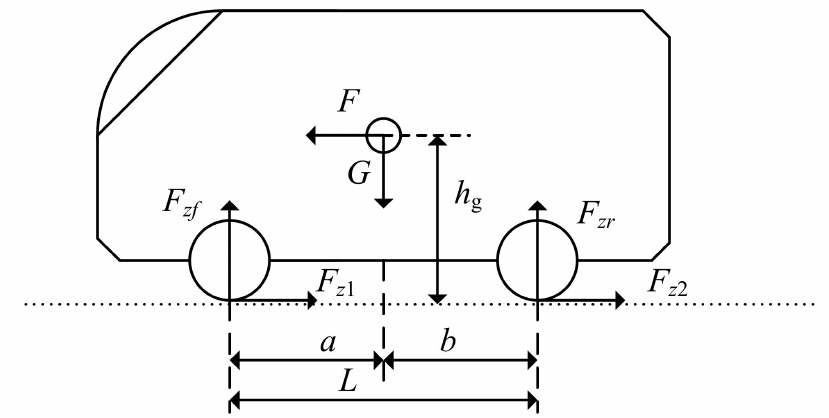
Figure 1. Dynamic force analysis of the pure electric bus when braking. The meanings of the symbols in Figure 1 are as follows: a is the distance from the center of mass of the vehicle to the centerline of the front axle, which is 3728 mm; b is the distance from the center of mass of the vehicle to the centerline of the rear axle, which is 2372 mm; h g is the height of the center of mass of the vehicle, which is 596 mm; L is the wheelbase, which is 6100 mm; G = m g is the gravity of the whole vehicle, and m is 12,000 kg; g is the acceleration of gravity, which is 9.8 m/s 2 ; F zf and F zr are the normal opposite forces generated by the ground on the front and rear axles of the vehicle, respectively, and the unit is N; F z 1 and F z 2 are the braking forces generated by the ground facing the front and rear wheels respectively, and the unit is